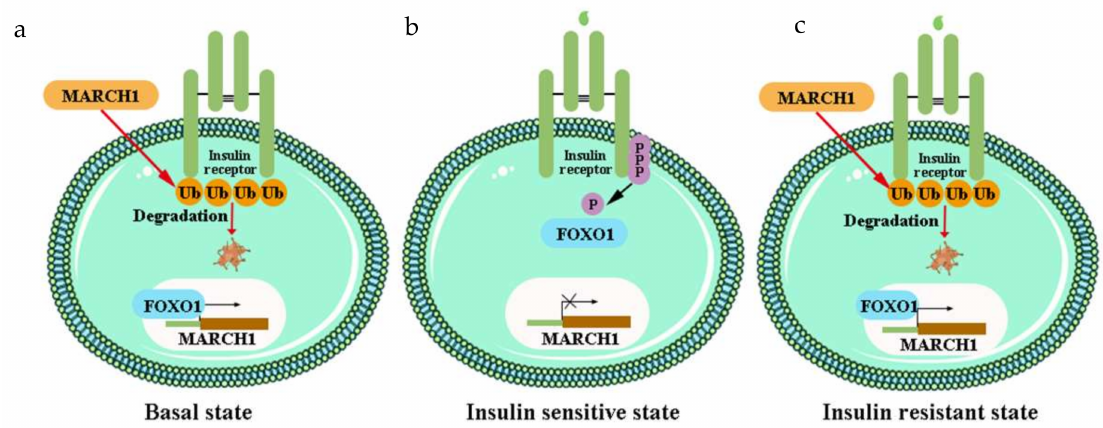
Figure 7. MARCH 1 regulates the IR: ( a ) MARCH 1 ubiquitinates and degrades the β -subunit of the IR, thereby decreasing IR surface expression; ( b ) IR activation inhibits FOXO, resulting in transcriptional repression of MARCH 1 and an increase in surface IR levels; ( c ) Insulin fails to inhibit FOXO, leading to enhanced MARCH 1 expression, reduced surface IR levels, and an impaired IIS pathway. Ub, ubiquitin. FOXO, forkhead transcription factor subgroup O.